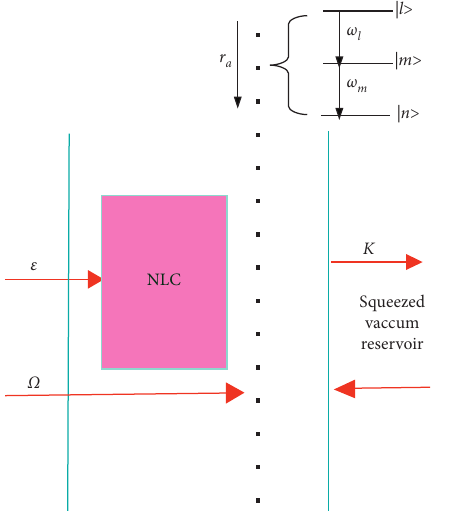
Figure 1: Schematic representation of a correlated emission laser with a nonlinear crystal (NLC) and coupled to a two-mode squeezed vacuum